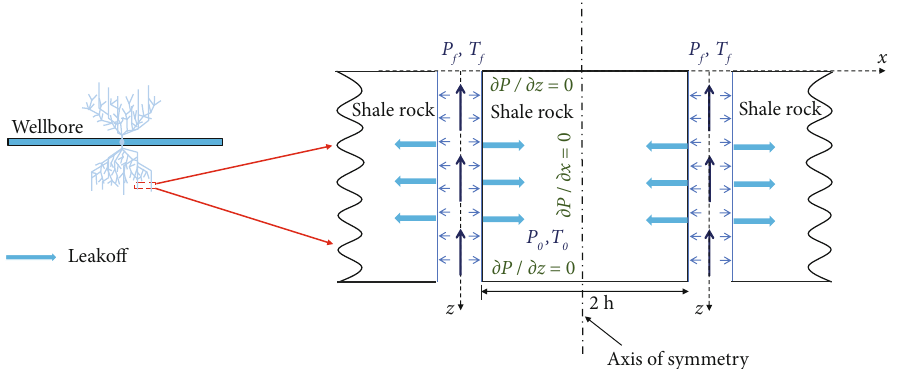
Figure 3: The red dashed box zooms in to two consecutive fractures and shows the fracture geometry with the initial and boundary conditions: P and T are the fl uid pressure and temperature, respectively. P 0 and T 0 are the initial pressure and temperature, f f respectively. The 1D solution is limited to h because of the symmetry.